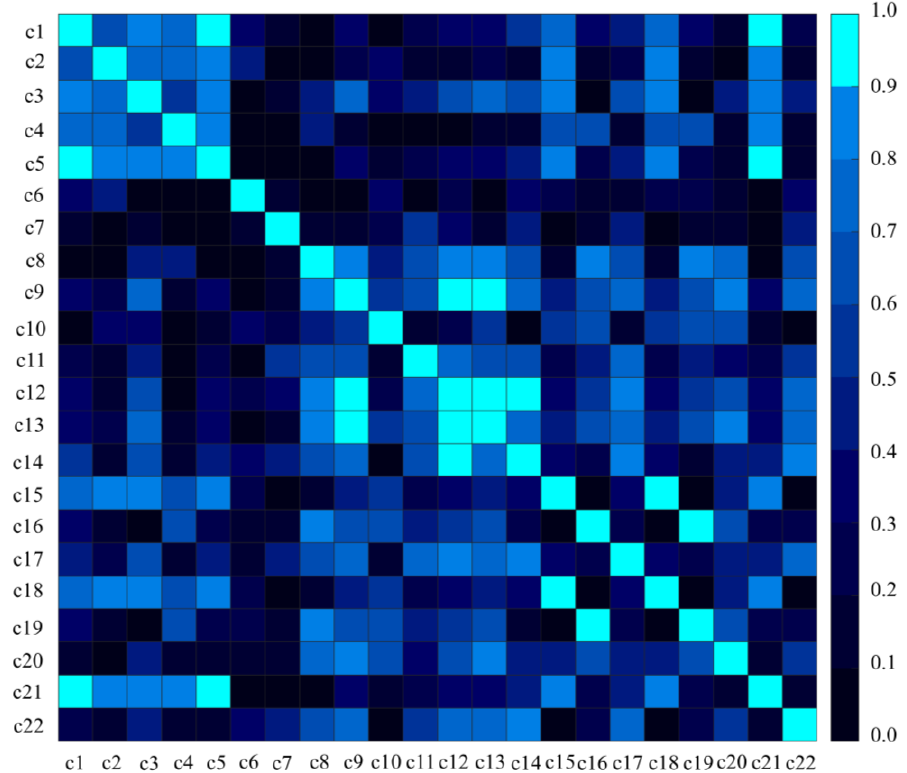
Figure 8. The absolute value of the Spearman correlation between the extracted features from the simulated CP SAR